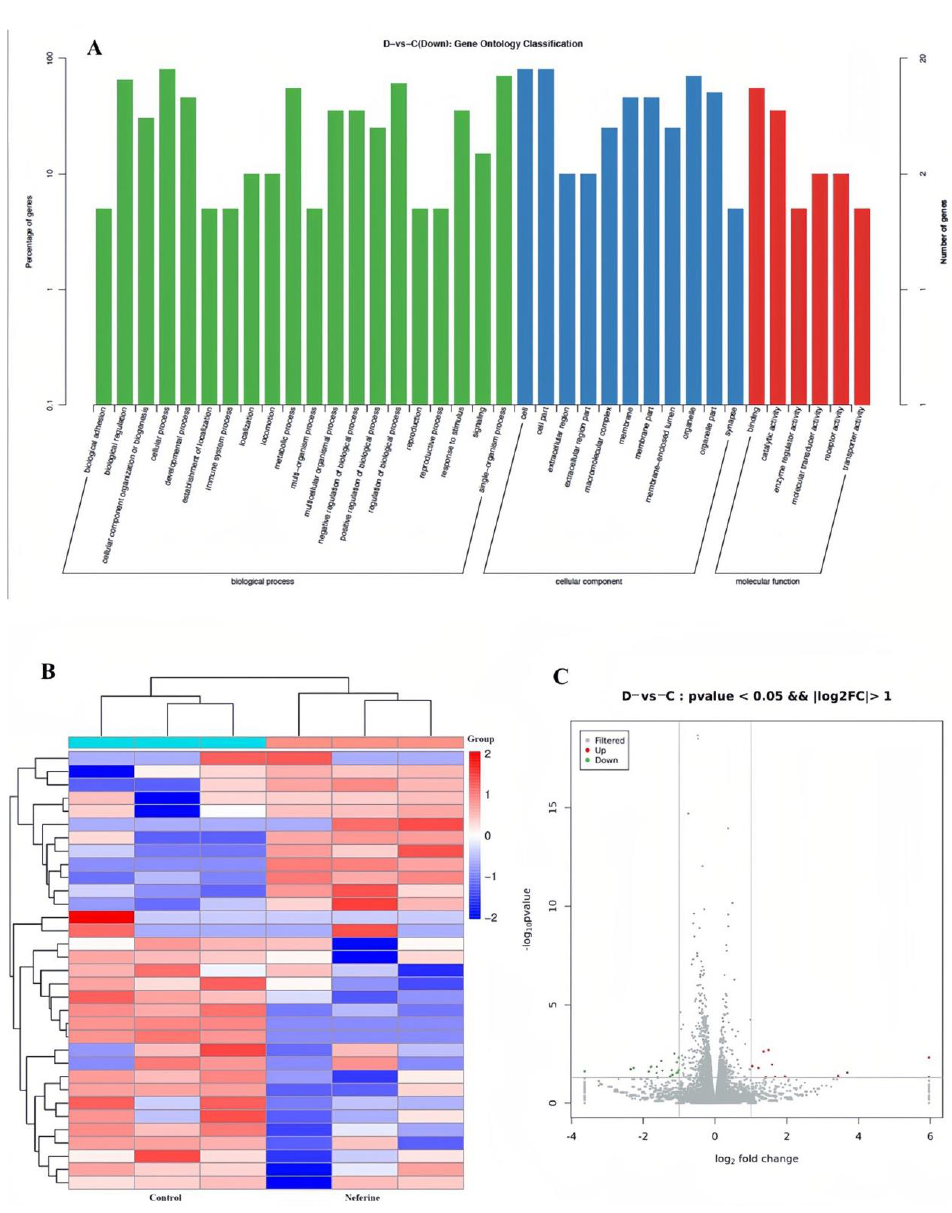
Figure 3. Quantification of transcriptome profiles in CHO cell treated with neferine. (( A ) GO enrich- ment analysis of the main biological and cellular process; ( B ) hierarchical clustering and heatmap of the correlation gene expression profiles; ( C ) volcano plot indicated different gene expression